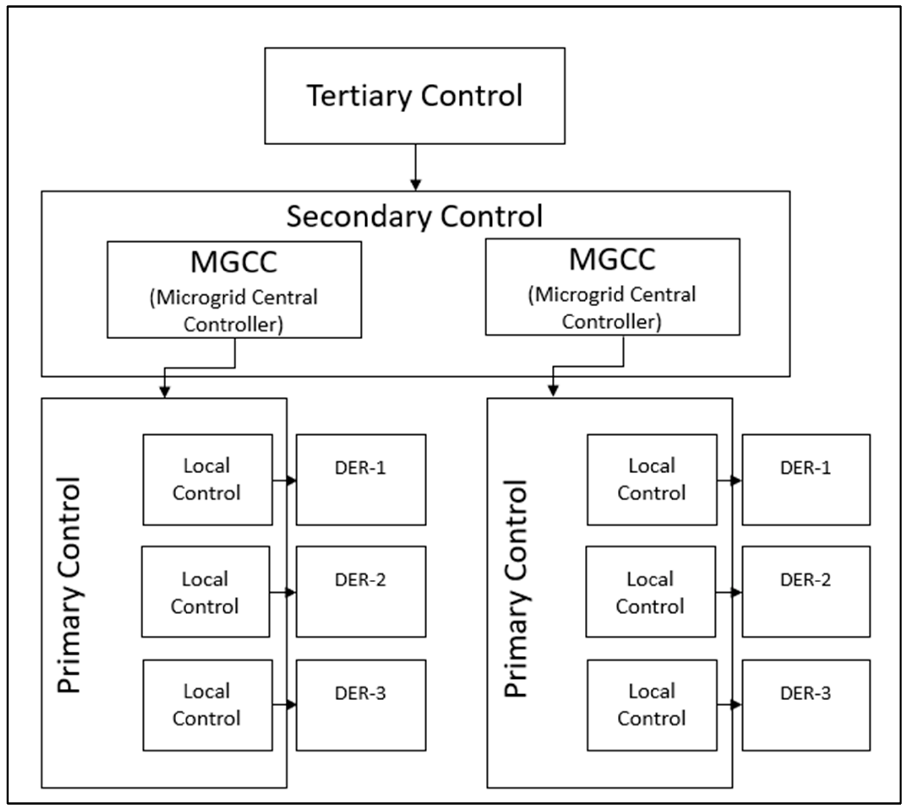
Figure 11. Sample architecture of hierarchal control in a microgrid.